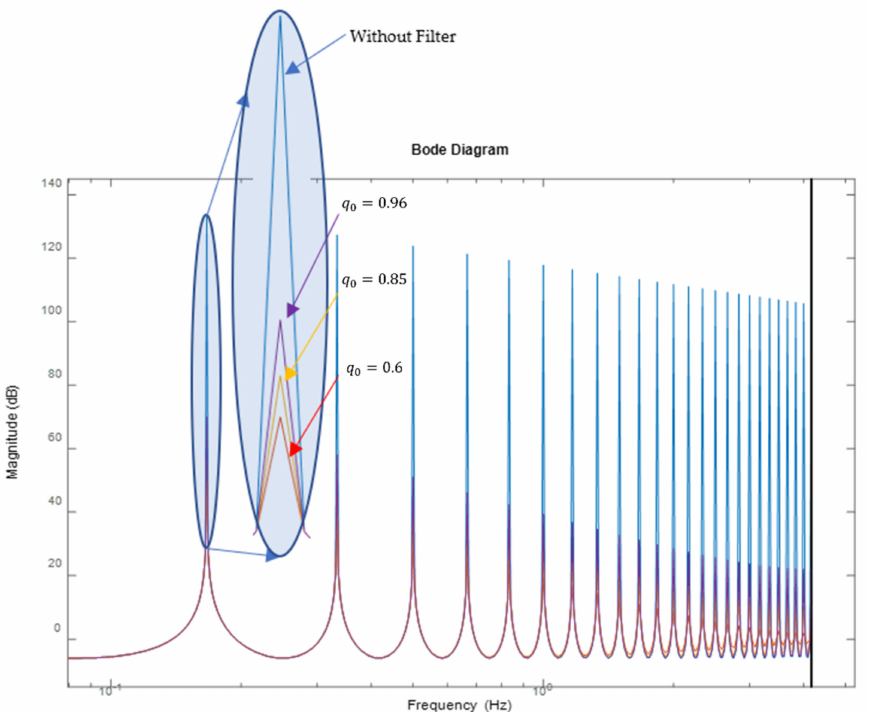
Figure 14. Bode diagram of the internal models (red, yellow, purple: with filter; blue: without filter).